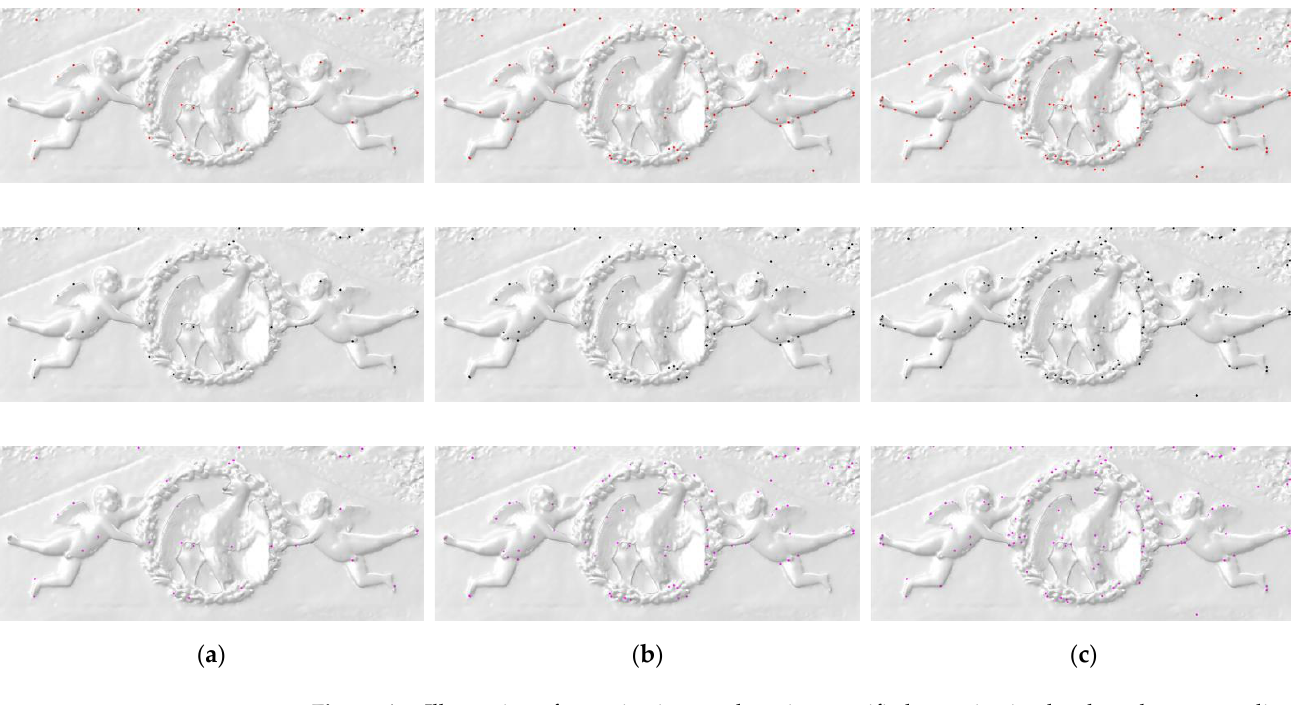
angelo-2R.obj, ( e ) angelo-1R.obj) rendered and texturized by the color map in accordance with all computed criteria from Table 1 and Section 4.2. Blue corresponds to low values and red to high values of the computed criteria.